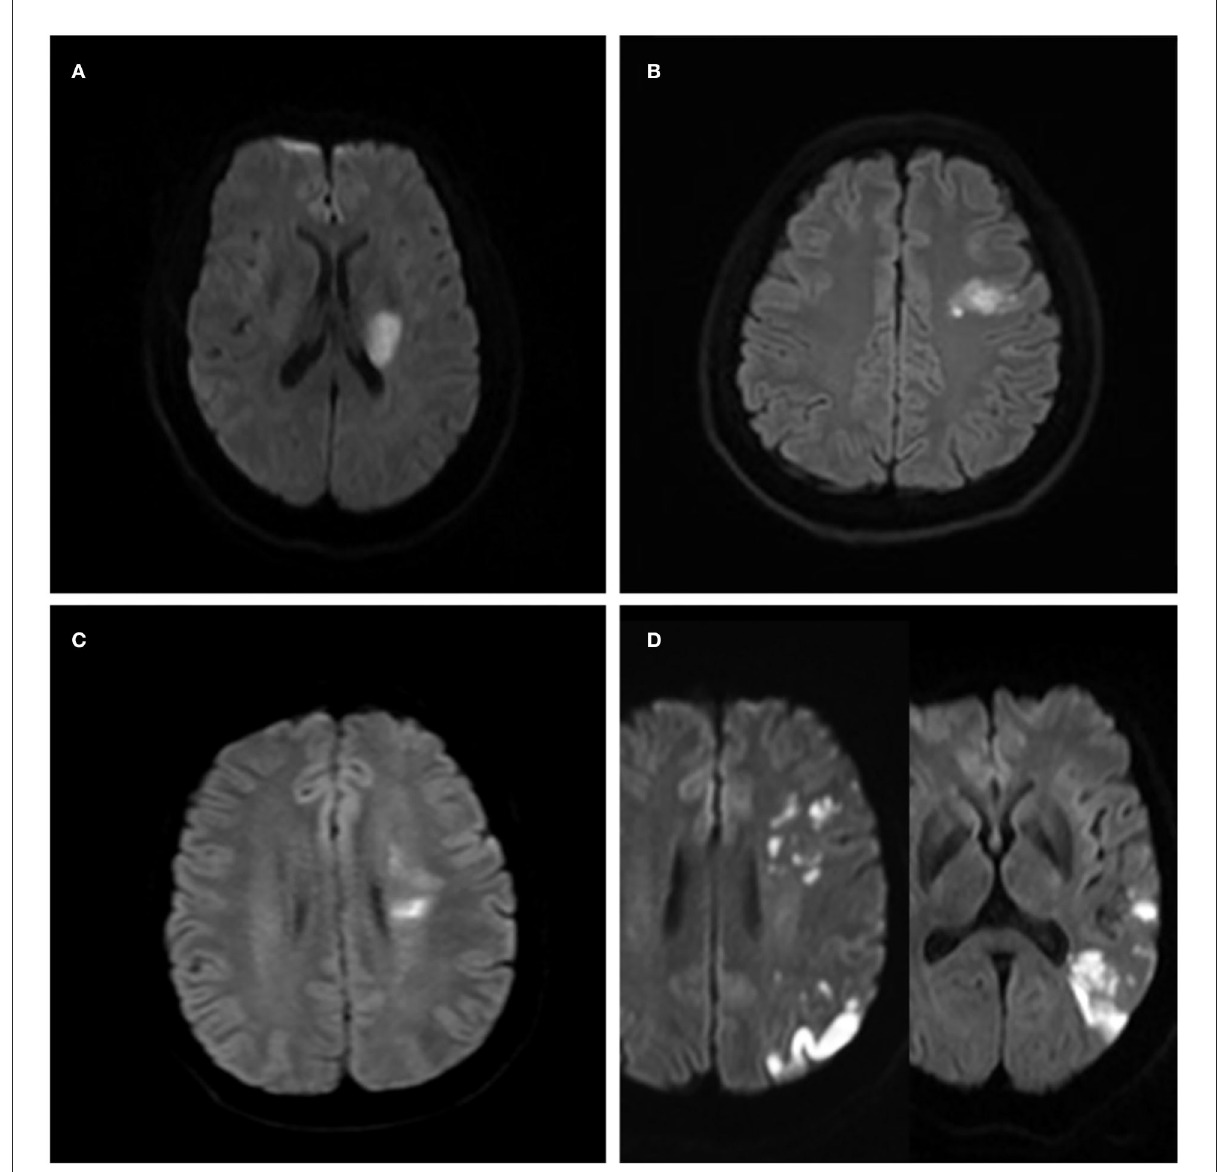
FIGURE2 Ischemic lesion patterns indicating the different stroke mechanisms in four patients with the symptomatic middle cerebral artery (MCA) atherosclerotic stenosis. (A) A case of isolated acute infarction in the area of the perforating artery suggests parent artery atherosclerosis occluding a penetrating artery. (B) Local infarction indicating a probable artery-to-artery embolism. (C) Internal watershed infarctions indicating probable hypoperfusion. (D) Multiple cortical and wedge-shaped infarctions indicating a probable mixed mechanism of artery-to-artery embolism and